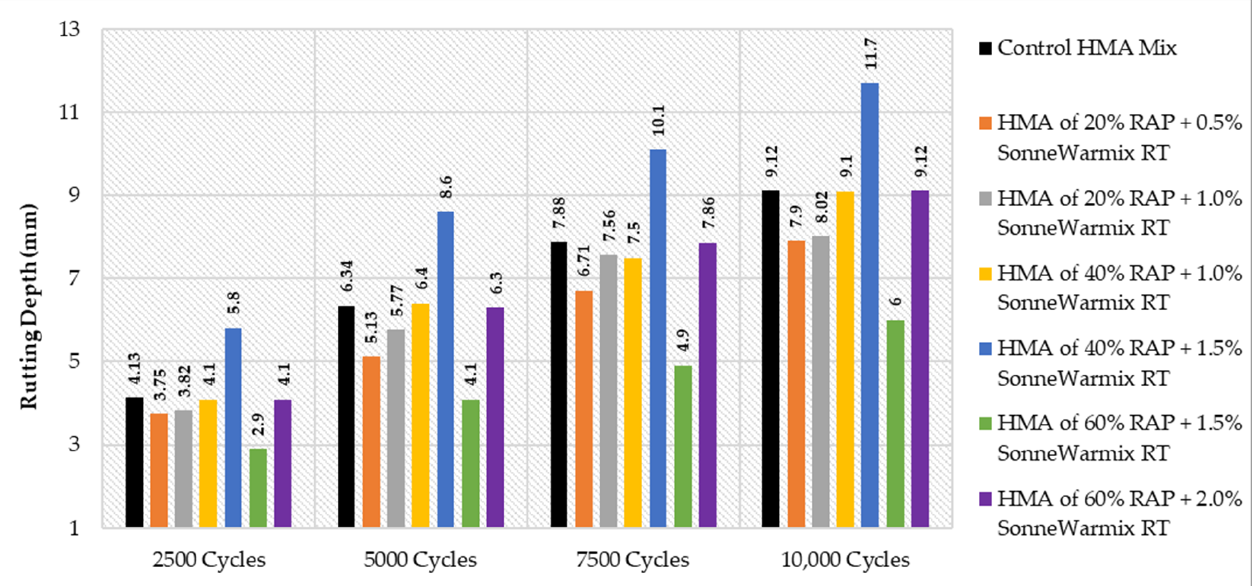
Figure 28. Rutting depths of recycled HMA mixtures rejuvenated by SonneWarmix RT TM . Table 22. The optimum percentages of the used rejuvenators.